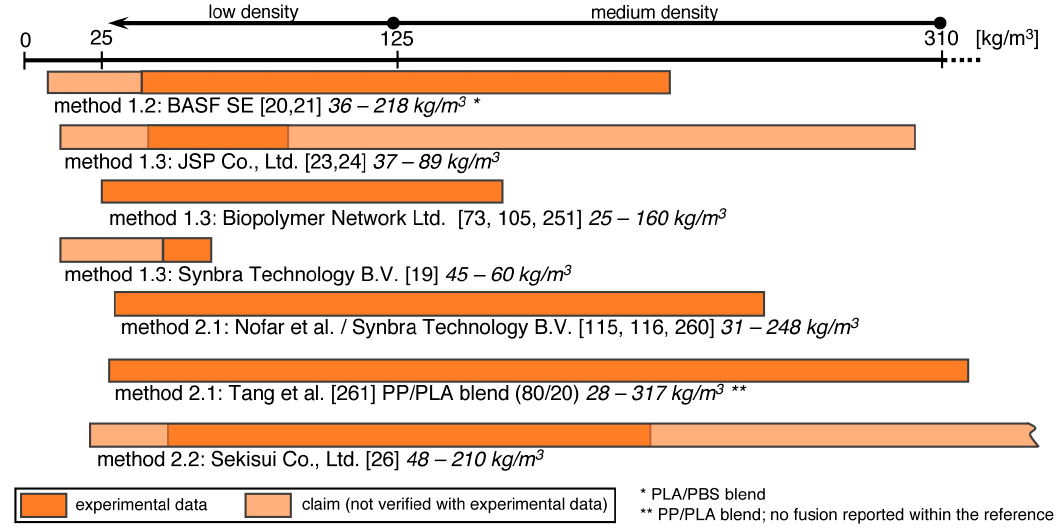
Figure 11. Literature overview of achievable density ranges for expandable PLA (EPLA).